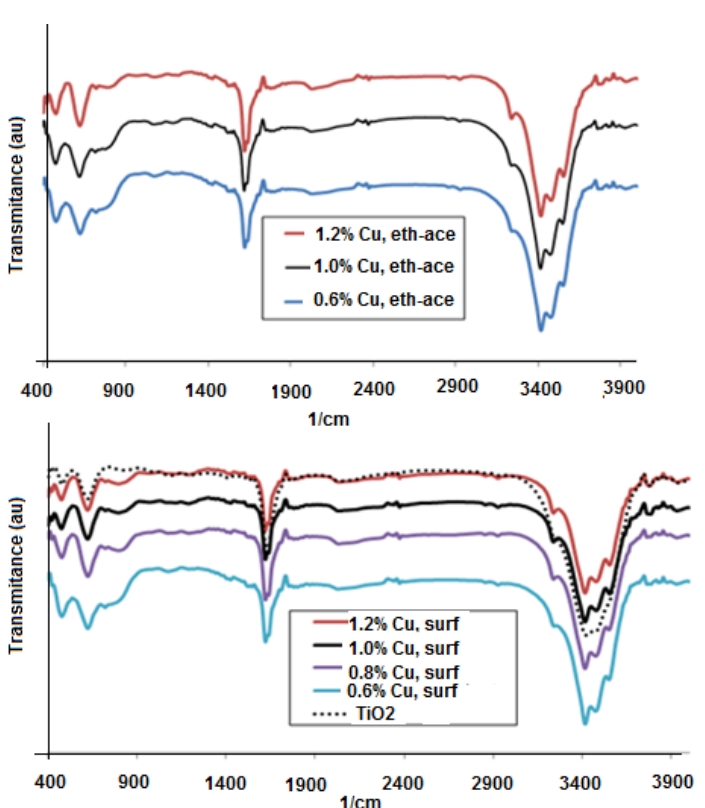
Fig. 2. FTIR spectra of TiO and Cu/ TiO samples prepared in two different 2 2 Fig. 2 FTIR spectra of TiO 2 and Cu/ TiO 2 samples prepared in two different media